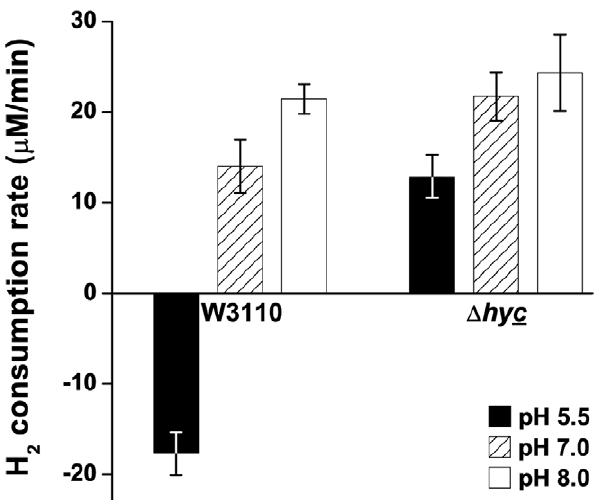
Figure 6. Effect of aeration on the extreme acid survival of W3110, D hybC , D hycE , and D hypF . The white bars represent cultures grown with aeration to stationary phase in LBK buffered at pH 5 that were diluted 200-fold into LBK pH 2 and exposed for 2 h with aeration at 37 u C. The hatched and black bars represent anaerobic cultures grown to stationary phase in LBK buffered at pH 5.5 that were diluted 200-fold into LBK pH 2.5 (hatched) or pH 2 (black) and exposed for 2 h without aeration at 37 u C. Aerobic and anaerobic cultures were maintained as stated in the Materials and Methods. Error bars represent SEM, n=5 or